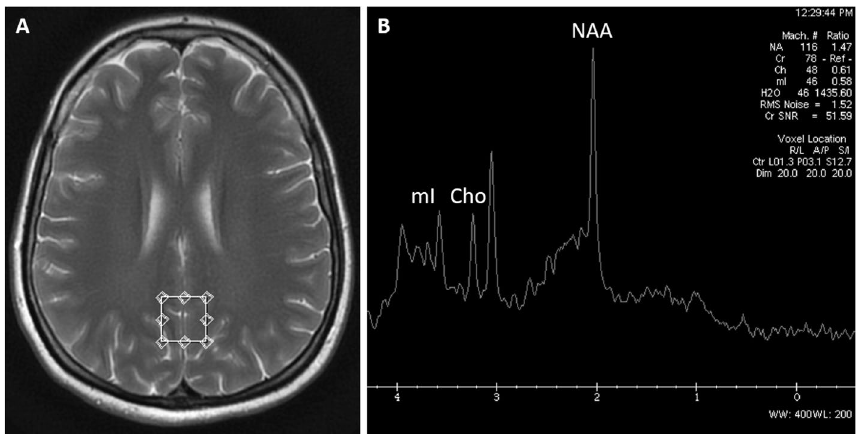
Figure 1. MR spectroscopy: axial T2-weighted image (A) showing a single voxel placed in the posterior cingulate gyrus region (PCG). The obtained spectrum (B) revealed a decrease in the NAA/Cr ratio in PCG. Figures source: Department of General and Interventional Radiology and Neuroradiology, Wroclaw Medical University; images performed with a with a 1.5 T SignaHdx MR scanner (GE Healthcare).